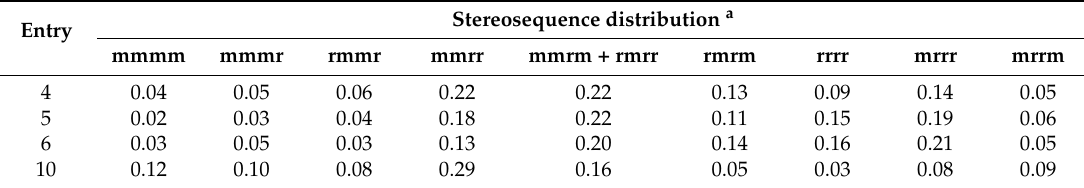
Table 5. Steric pentad distributions for samples in Table 3 (entries 4–6 and